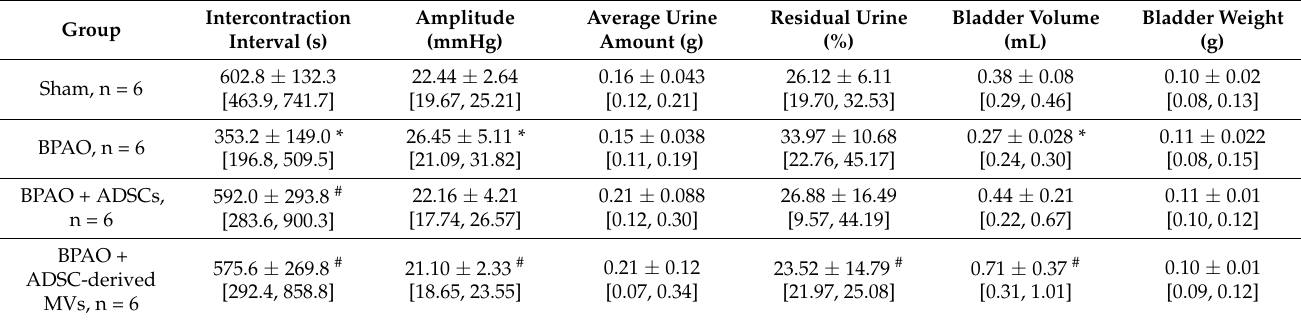
Table 2. Detailed data of transcystometrogram. Data are presented as mean ± standard deviation; the 95% confidence intervals are shown in brackets. * p < 0.05 vs. sham group by two-tailed non-paired Student’s t -test. # p < 0.05 vs. BPAO group by two-tailed non-paired Student’s t -test.